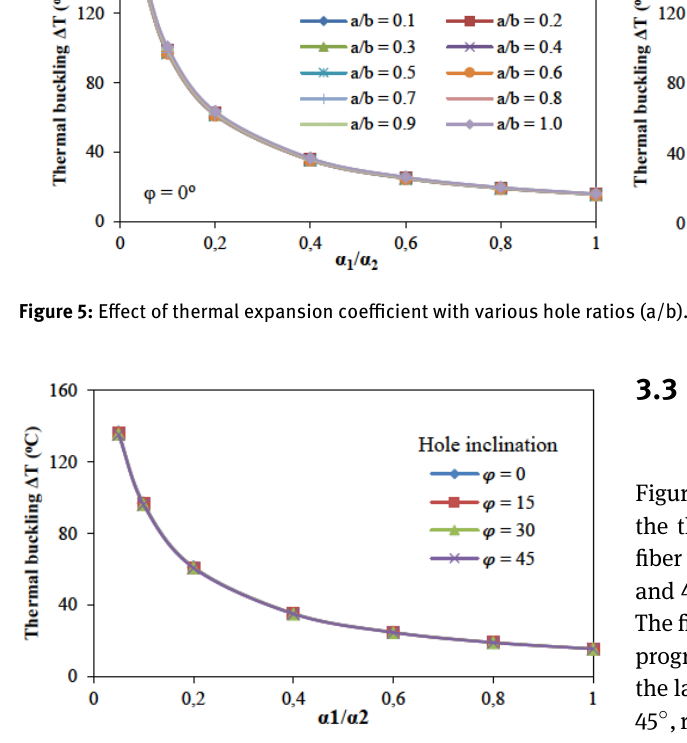
Figure 6: Effect of thermal expansion coeflcient with various hole inclinations (in the case a/b =